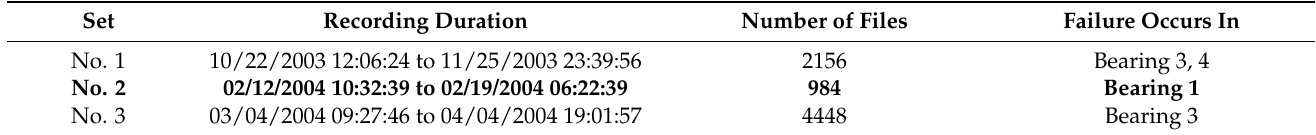
Table 2. Description of three sets belonging to IMS bearing dataset.